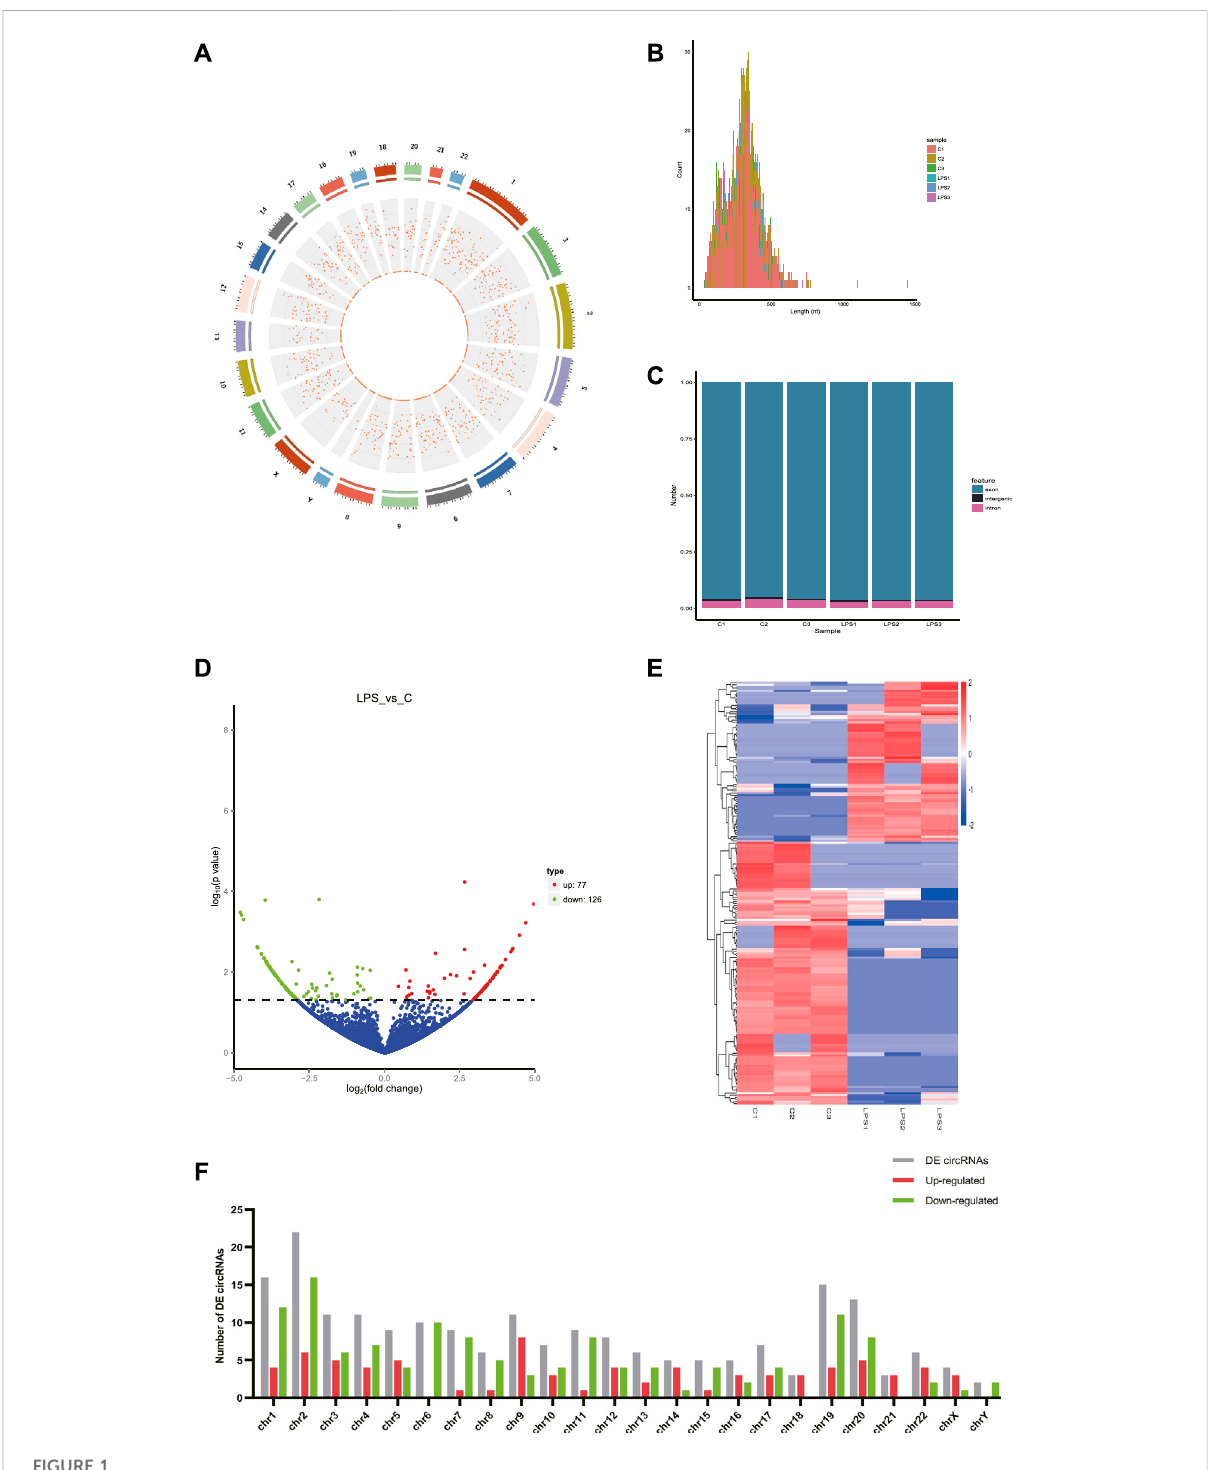
FIGURE 1 CircRNAs in LPS-induced sepsis. (A) The distribution of all cricRNAs in sepsis. The outermost layer was a chromosome map of the human genome.ThereddotsintheinnercirclesrepresentedthecircRNAs. (B) ThelengthofthecircRNAofallsamplesandthesourceofthecircRNAswere represented. (C) The source of all circRNAs. (D) Representative volcano plot showing the up- and down-regulated circRNAs in the cells treated with or without LPS. Red dots represent up-regulated transcripts, green dots represent down-regulated transcripts, and blue dots represent genes without a signi fi cant change. (E) Cluster analysis of all differentially expressed transcripts. Up- and down-regulated circRNAs are colored red and blue, respectively. (F) Distribution of DE circRNAs on chromosomes. (C) Control groups. LPS: LPS